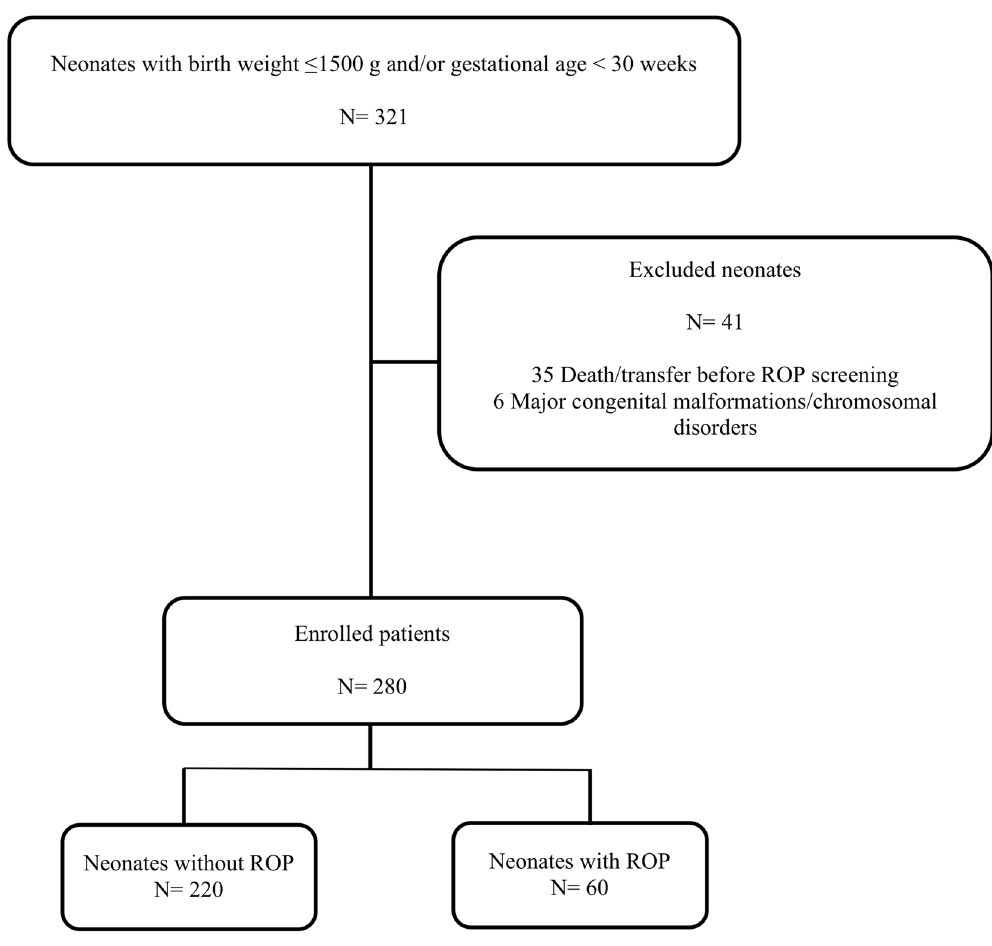
Figure 1. Study flow diagram. ROP, Retinopathy of